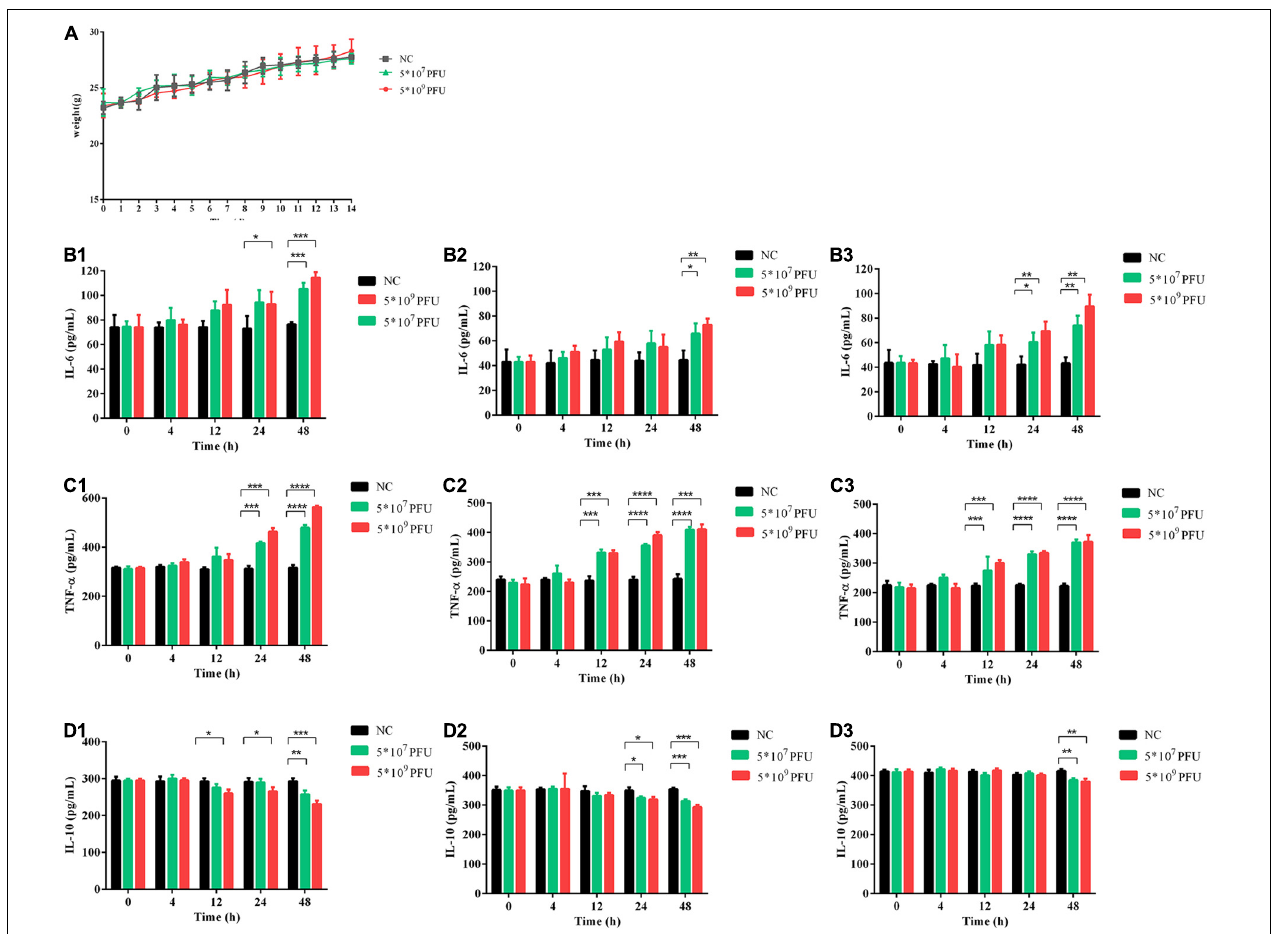
FIGURE 4 | Safety evaluation of phage vB_Kox_ZX8 in mice. (A) The weight of mice after injection with phage vB_Kox_ZX8; IL-6 levels in the (B1) serum, (B2) liver, and (B3) spleen of mice after injection with phage vB_Kox_ZX8; TNF- α levels in the (C1) serum, (C2) liver, and (C3) spleen of mice after injection with phage